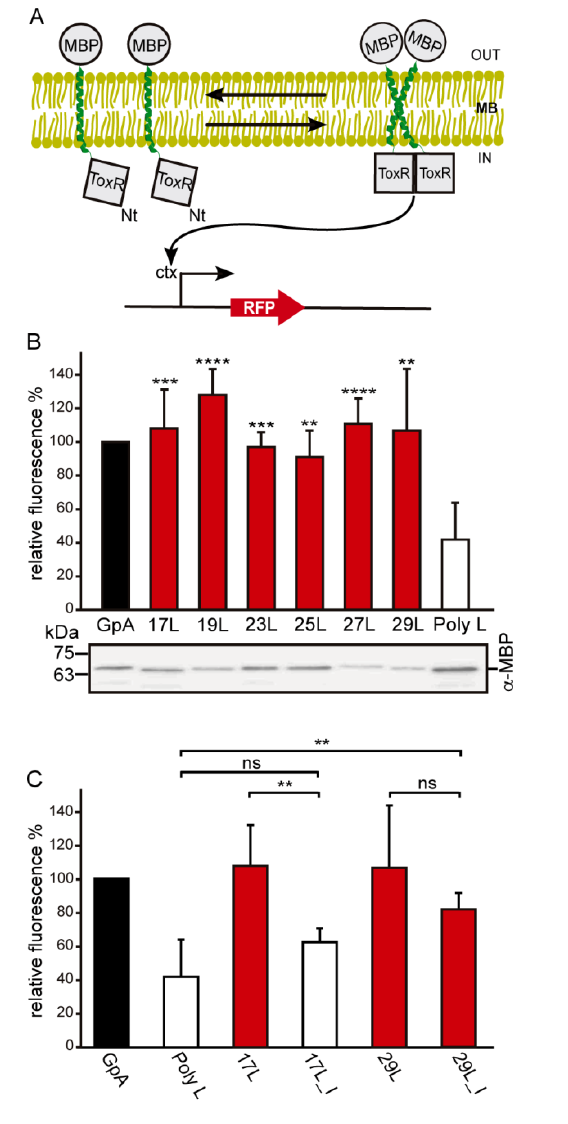
FIGURE 1: Homo-dimerization in E. coli membranes. (A) Schematic representation of ToxRED Assay. TM-driven oligomerization results in dimerization of ToxR transcriptional activator which, ultimately, drives the expression of the red fluorescence protein RFP (encoded under ctx promoter). The c-terminus maltose binding protein (MBP) located in the periplasm (OUT) allows growth of E. coli MM39 strain in M9 minimal media supplemented with 0.8% of maltose. (B) Mean relative fluorescence of chimera homo-oligomerization. Error bars denote standard deviation obtained from at least 6 independent experiments (p-values for the comparison with poly L: ** <0.01, *** <0.001, **** <0.0001). The color intensity-code was used to highlight dimerization (red) vs non-dimerization (white). The positive control (GpA homo-dimer) is shown in black. The α-MBP western blot under the bar graph shows chimera’s expression levels. (C) Contribution of Gly for the dimerization of TM chimeras. Mean relative fluorescence of 17L, 29L, 17L_I, and 29I_L chimeras homo-oligomerization. Error bars denote standard deviation obtained from at least 4 independent experiments (p-values for the comparison with poly L: ** <0.01, ns non-significant). The color intensity-code is used to highlight dimeri- zation (red) vs non-dimerization (white). Positive control (GpA homo- dimer) is highlighted in